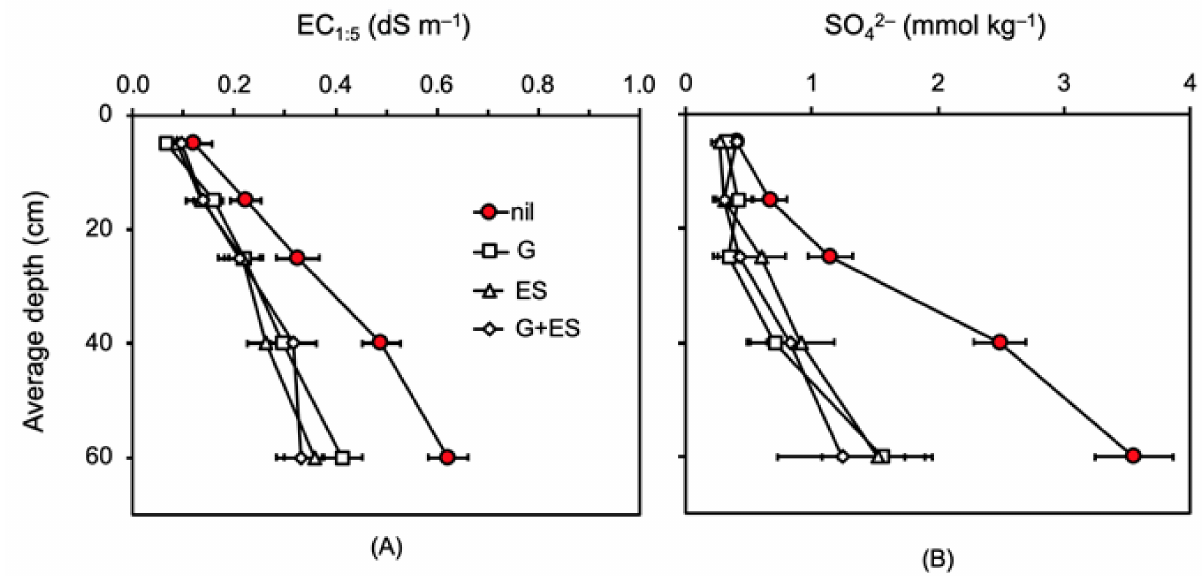
Figure 4. Effects (at 31 days after sowing) of depth and amendment (nil, G, ES, or G+ES) on: ( A ) EC 1:5 , and ( B ) SO 42 − concentration. Points are the average of four replicates. Error bars indicate the standard error of the mean. In each case, there was a significant effect of depth ( p < 0.001), a significant main effect of amendment ( p < 0.01) and a significant interaction between depth and amendment ( p < 0.001). Amendments were: nil, gypsum (G), elemental sulfur (ES), and gypsum plus elemental sulfur (G+ES). The soil was a Vertic Calcic Calcisol located on Merredin Research Station ( − 31 ◦ 30 (cid:48) 25 (cid:48)(cid:48) S, 118 ◦ 13 (cid:48) 04 (cid:48)(cid:48)